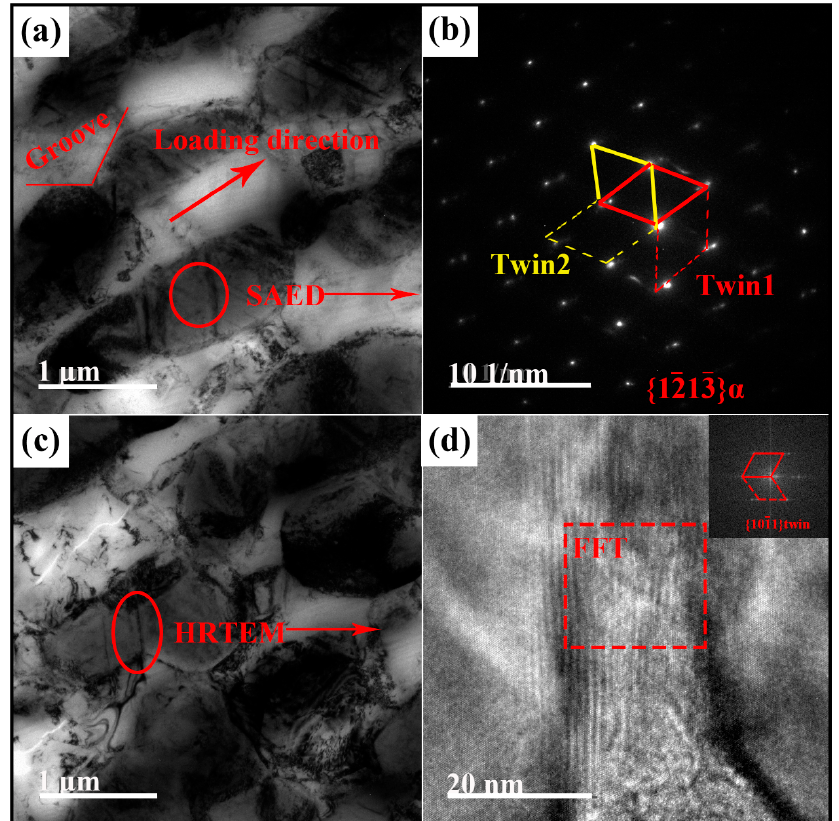
Figure 5. ( a , c ) TEM images of microstructural deformation characteristics of equiaxed α plates in sample HR-BM. ( b ) Selected-area di ff raction pattern along the 1213 zone axis showing crossing twins identifiedastwotwinvariantsofthe 1101 twinningsystemintheelongated α plate. ( d )High-resolution TEM image of a localized shear band in the α particle in ( c ) and the corresponding fast Fourier transform (FFT) image verifying that the localized shear band is a 1011 twin